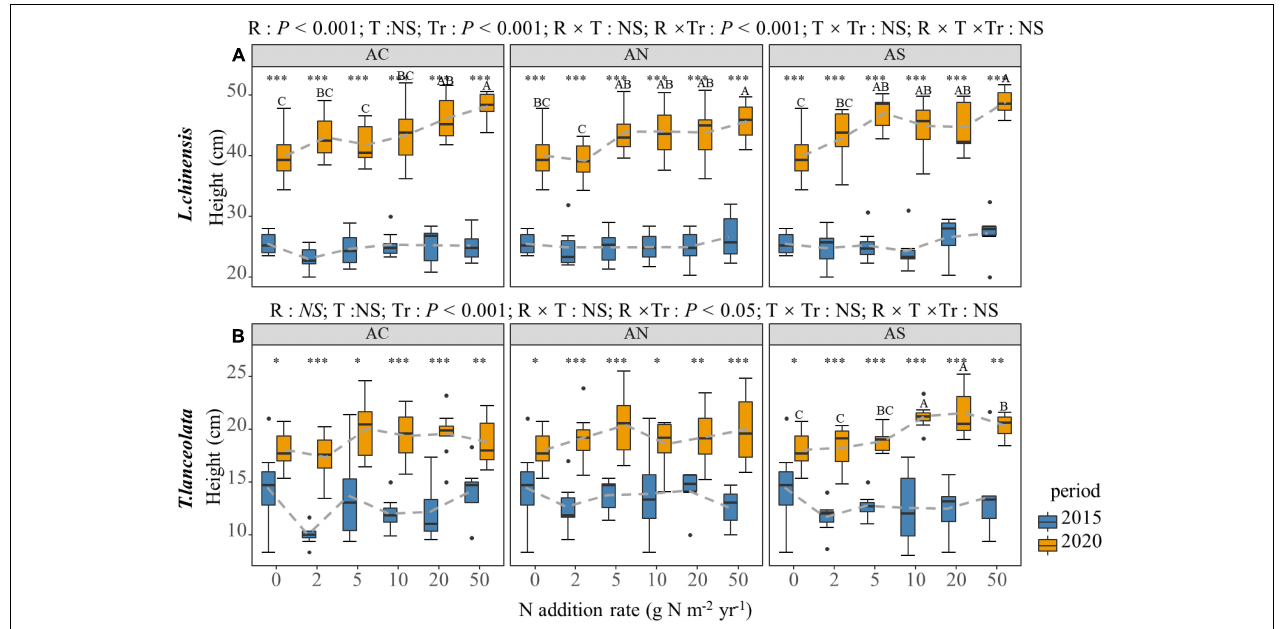
FIGURE 4 | Effects of short- and long-term nitrogen deposition on H of two species: (A) Leymus chinensis ; (B) Thermopsis lanceolata . The three-way ANOVA was used to test the effects of Pr, T and R on H. The effects of the nitrogen compound type alone and with nitrogen addition rate and year on H are not significant (NS, P > 0.05), thus one-way ANOVA (Tukey’s HSD) and t -tests are used to test the effects of nitrogen addition rate and year on H. Different lower-case and upper-case letters indicate significant differences ( P < 0.05) in LN among nitrogen addition rate in the 2015 and 2020 plots, respectively. The asterisk above the picture indicates the significant difference between the two years under each nitrogen addition rate. Note: ∗ P < 0.05; ∗∗ P < 0.01; ∗∗∗ P < 0.001. CK: non-fertilizer control = 0, N1 = 2, N2 = 5, N3 = 10, N4 = 20, and N5 = 50 kg N ha − 1 yr − 1 ; AC (NH 4 HCO 3 ), AN (NH 4 NO 3 ), AS [(NH 4 ) 2 SO 4 ]. The gray dashed line is the connection of the mean